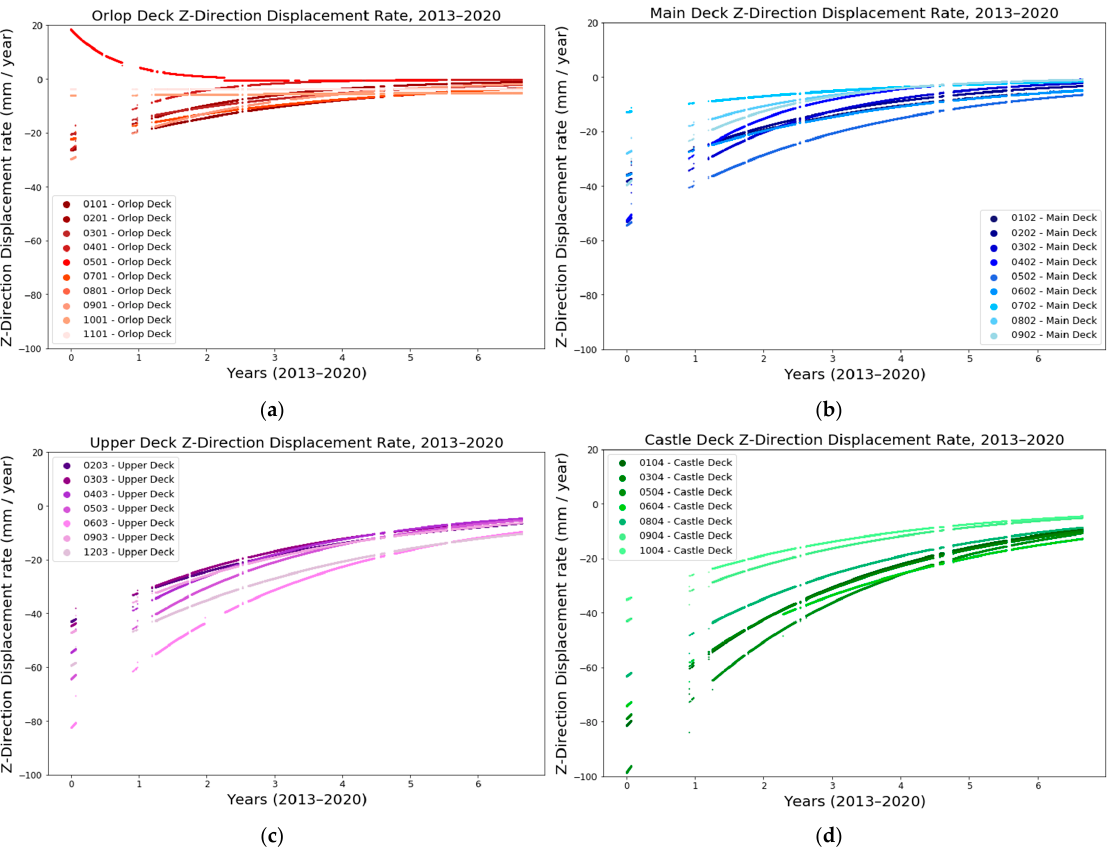
Figure 8. Rate of the Z displacement of the TS targets in the ( a ) orlop, ( b ) main, ( c ) upper and ( d ) castle decks plotted against time for the period between September 2013 and March 2020.